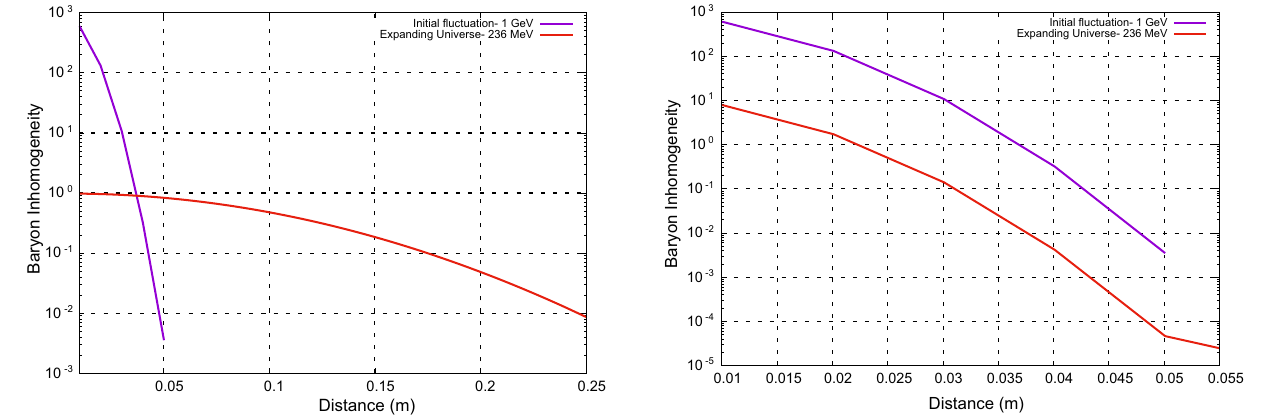
zero. That is why in Fig. 6 the plot is cut off at a distance 25 cm. Beyond this point, the inhomogeneity gradually goes down to zero. Wethusfindthattheinhomogeneitydecaysbythreeorders